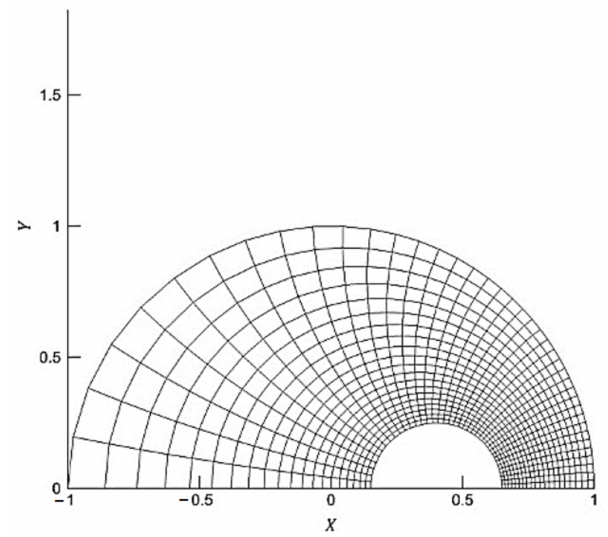
Figure 6. Generated grid in physical space for domain 1.